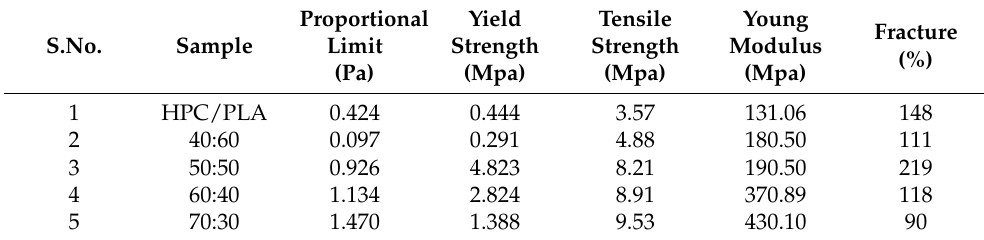
Figure 3. Correlation of ( a ) mechanical property ( b ) tensile strength ( c ) Young modulus. Table 3. Mechanical properties of